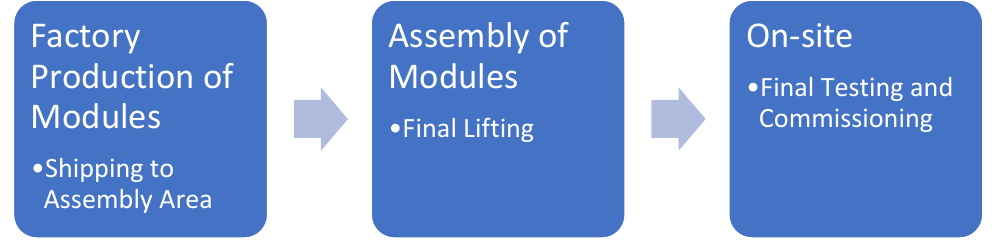
Figure 3. Modularization of production processes of a SMR.